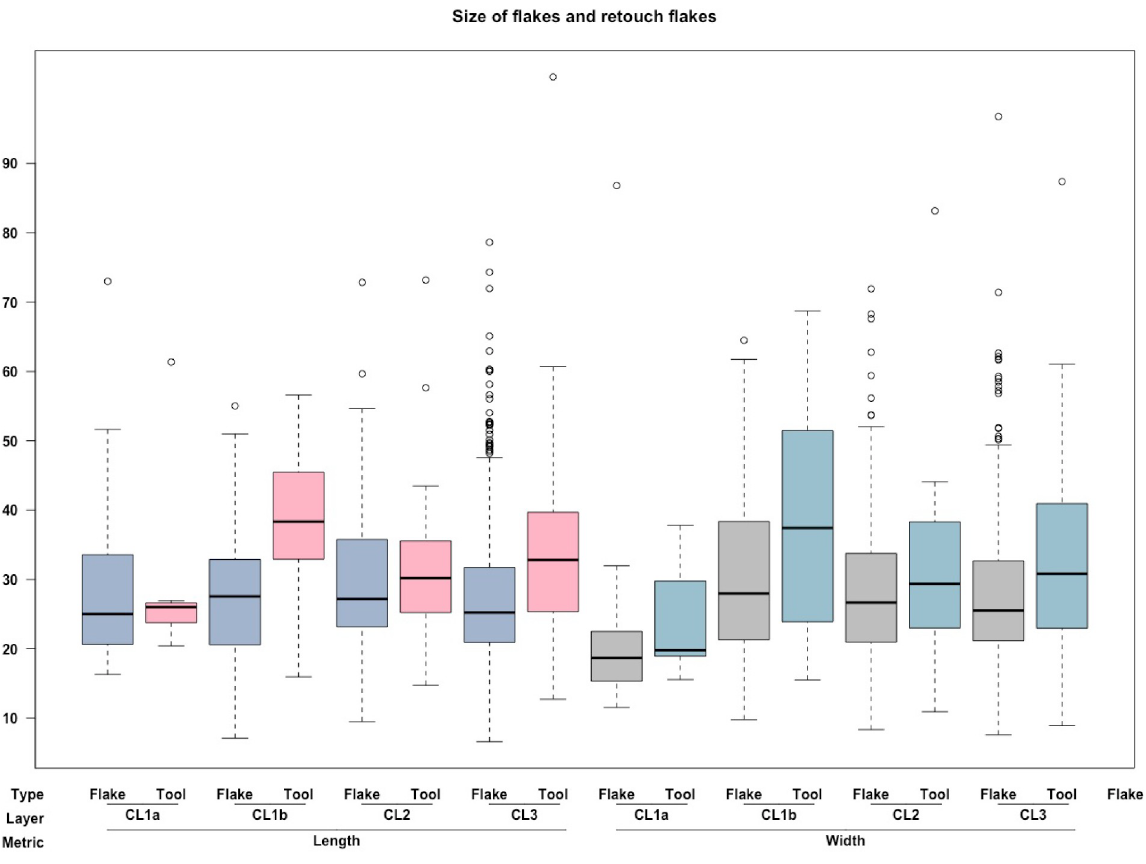
Fig 4. The length and width of flakes and